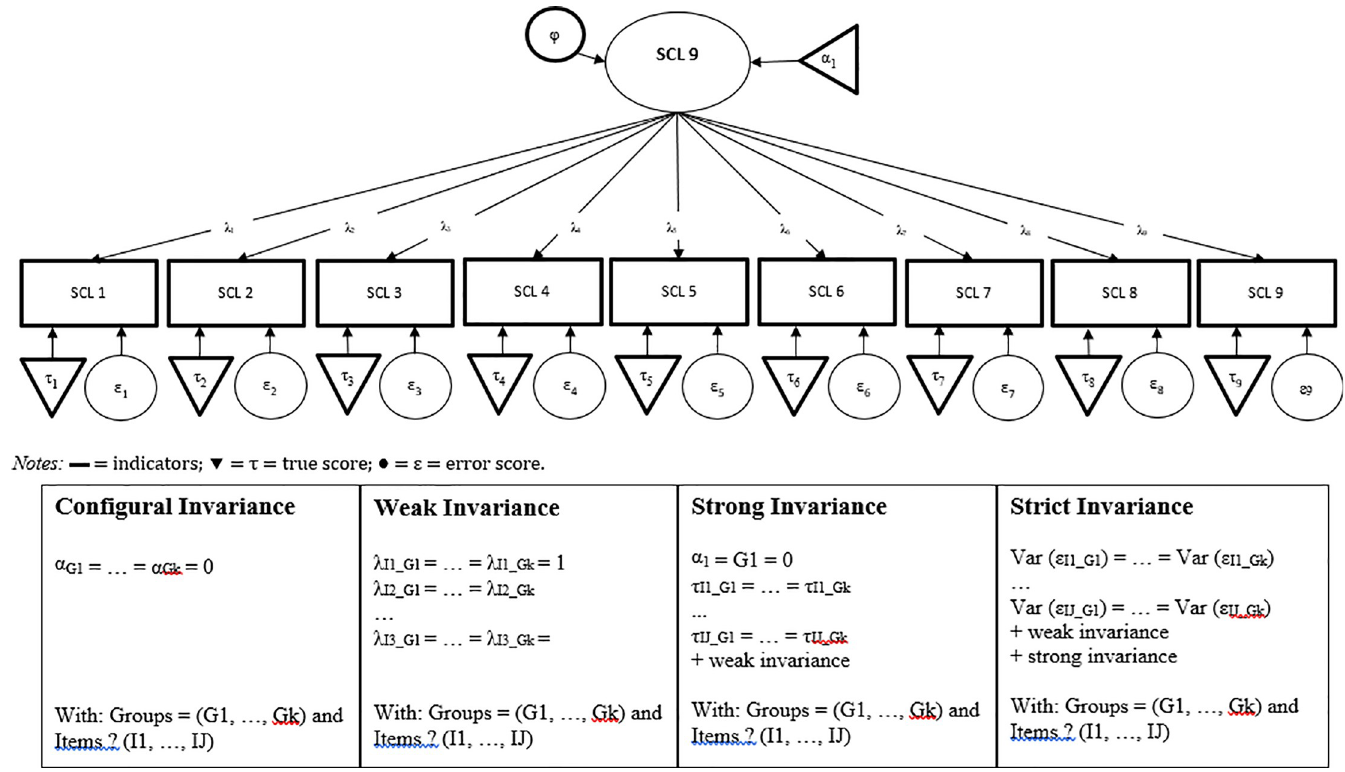
Fig 2. Models relevant for the invariance